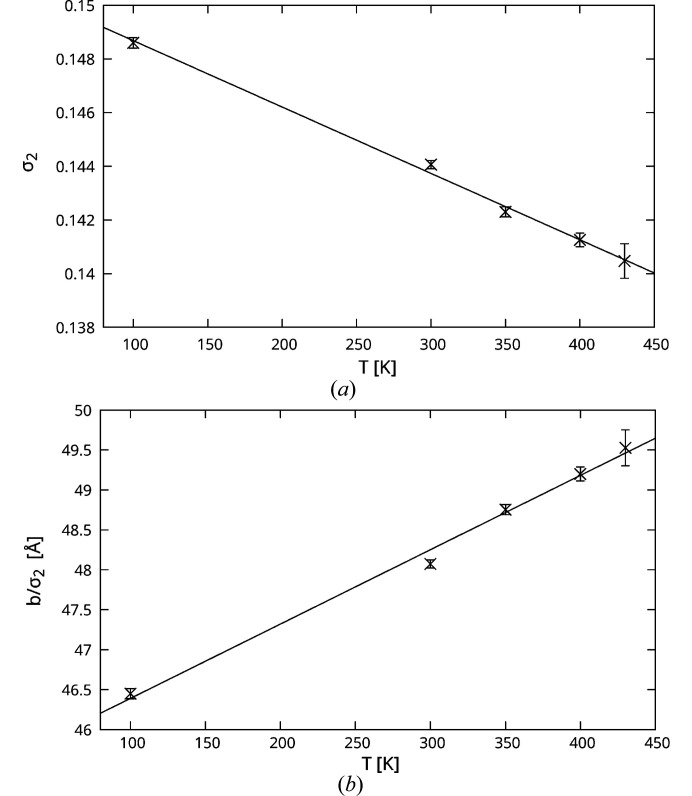
Evolution of (a) the σ2-component of the modulation wave vector and (b) the period b/σ2 of the modulation wave in [010] direction with temperature. Solid lines are linear least-squares regressions.